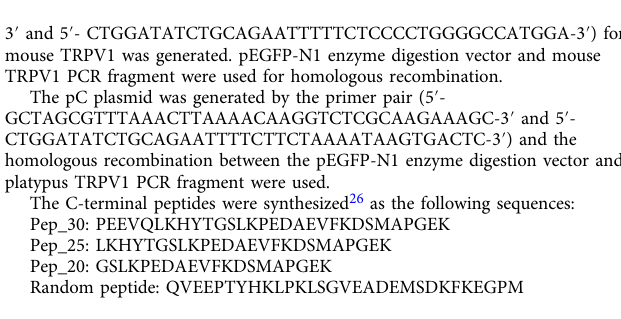
Fig. 6 Dh transition avoids in fl ammation and cell death during sustained heat. a Levels of TNF- α , IL- β , IL-6, and IL-8 in the left hind paw tissue before and after hot-plate assays ( n = 3, two-sided t -test: * p <0.01). b Western blotting showing the absence of apoptotic-like damage in the paw tissue of p- trpv1 mice. c Time-lapse microscopy images indicating the swelling of pV1-positive cell body at 40°C heating. mV1-positive cell body was intact at 40°C. Scale bar, 10 μ m. d The time-dependent cell volume of mV1 ( n = 20) and pV1 ( n = 20)-positive HEK293T cells, two-sided t -test: * p <0.01. Note that cytokines and western blotting are measured from the left hind paw tissue of female mice before and after six times of hot-plate assays. e A cartoon illustrating Dh ’ s structural mechanisms and role in mammals against sustained heat. All statistical data are given as mean±SEM. Source data are provided as a Source data fi